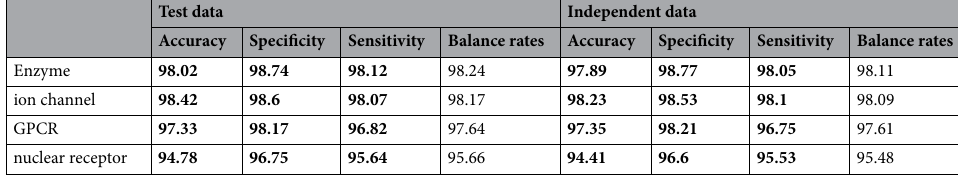
Table 6. Performance results of proposed method in test and independent data. Significant values are in bold.